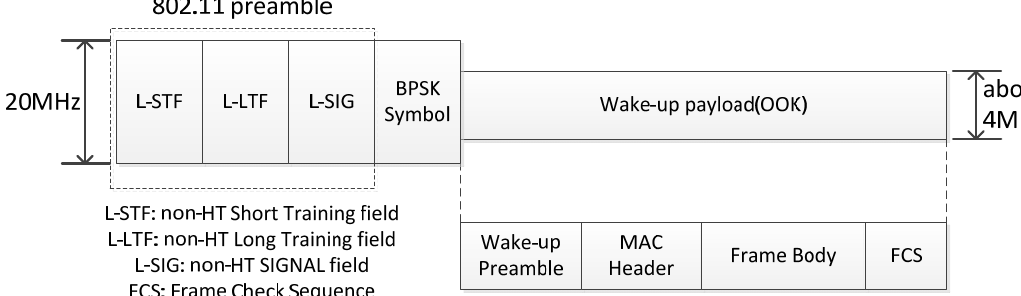
Figure 2. Structure of Wake-up symbol. BPSK = Binary Phase-shift Keying; MAC = Medium Access Control; HT = High Throughput.